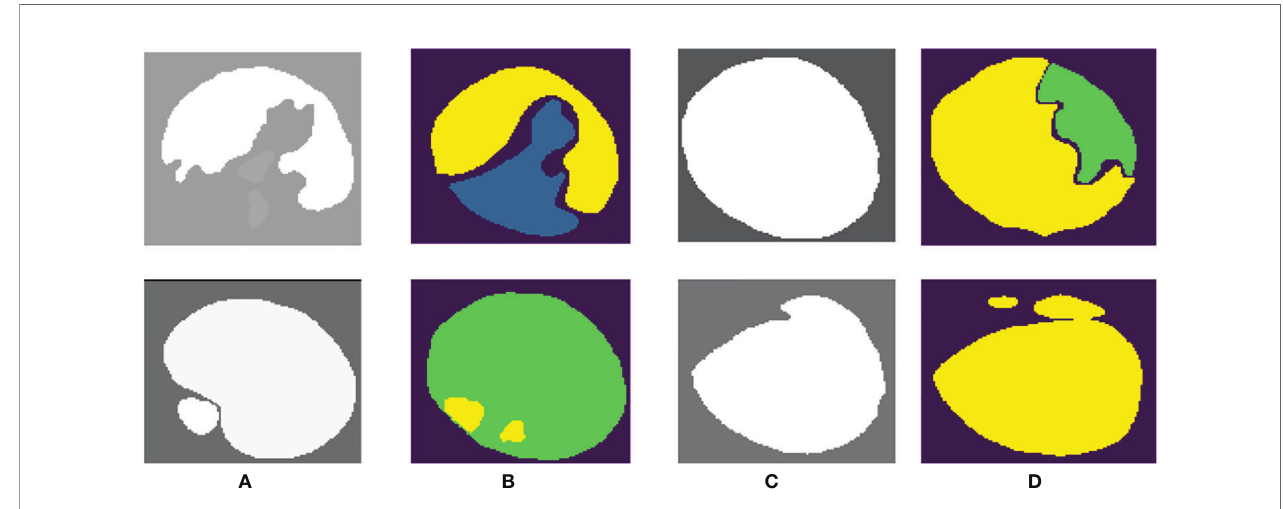
FIGURE 8 | Poor-performing images using our method. Columns (A, C) are the “ ground truth ” , and columns (B, D) are the fi nal segmentation